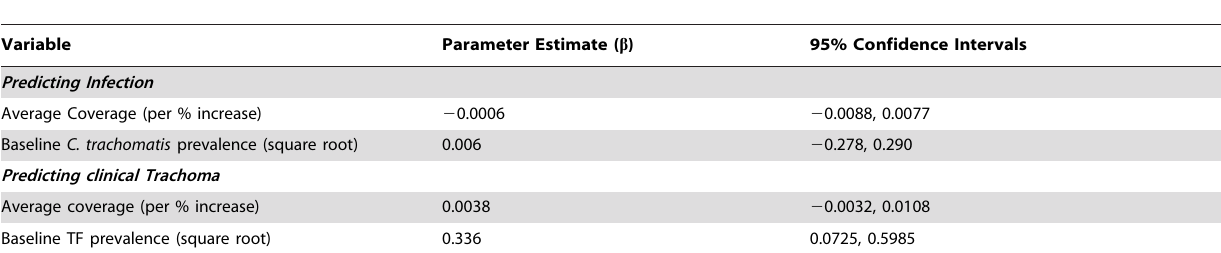
Table 4. Impact of actual coverage on prevalence of C. trachomatis and follicular trachoma at 36 months.